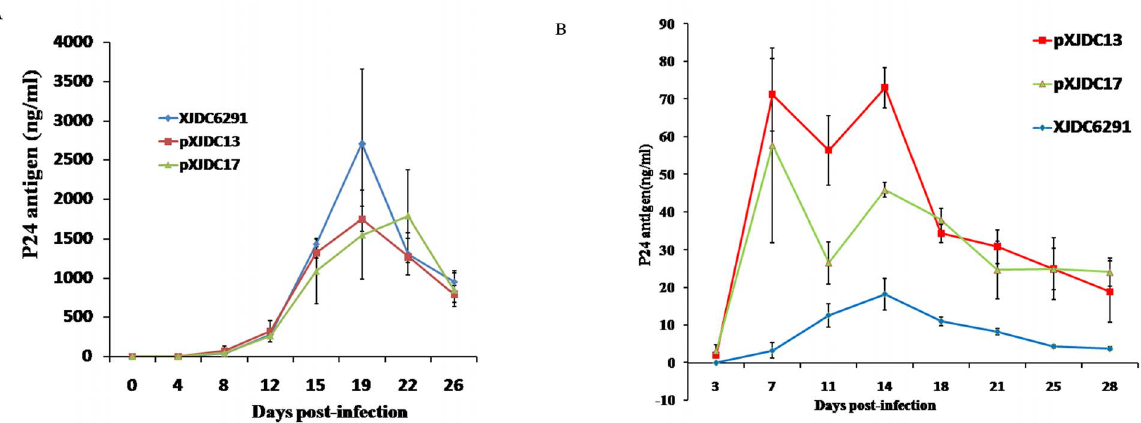
Figure 3. Replication kinetics of the viruses derived from the infectious molecular clone in comparison with parental isolate XJDC6291. 3 6 10 6 PHA-stimulated PBMCs or CD4 + T cells were infected with virus normalized at a TCID 50 of 10 4 in triplicate. Virus production was monitored by measuring HIV-1 p24 antigen concentration in culture supernatant every 2–3 days. The results shown are the mean value with standard deviations from three independent experiments. (A) Replication kinetics on PBMCs. (B) Replication kinetics on CD4 + T cells.